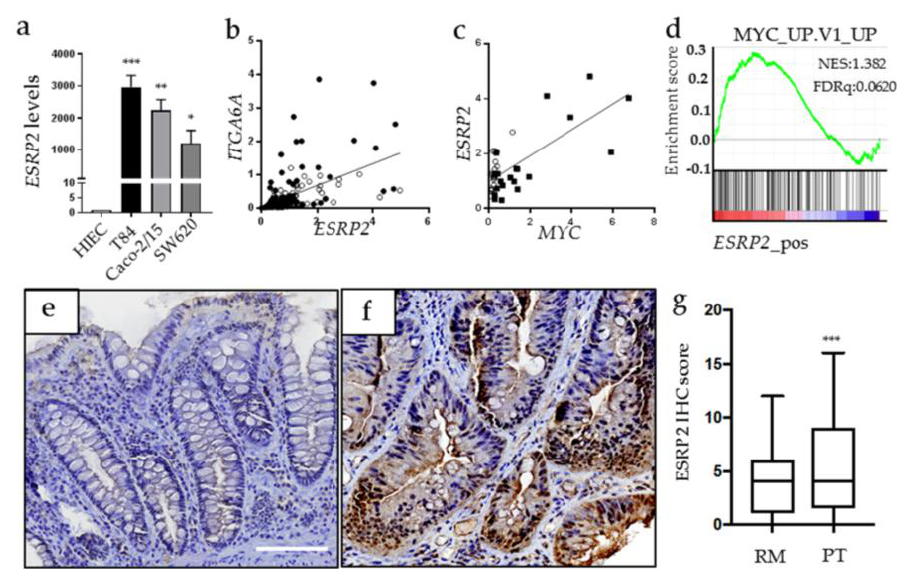
Figure 5. ESRP2 correlates with ITGA6A and MYC expression. ( a ) Evaluation of ESRP2 mRNA expression in normal human intestinal epithelial cells (HIEC) and a panel of CRC T84, Caco-2/15 and SW620 cells. * to ***: Statistically different ( p ≤ 0.05–0.001) from HIEC. ( b ) Correlation between ITGA6A and ESRP2 transcript expression in a set of 84 primary CRC tumors and their corresponding resection margins (RM). Pearson r = 0.5161, p ≤ 0.0001. ( c ) Correlation between MYC and ESRP2 transcript expression in a set of 20 primary CRC tumors and their resection margins (RM). Pearson r = 0.7243, p ≤ 0.0001. Open circle: RM; black square: CRC tumors. ( d ) GSEA plot of enrichment of MYC target genes of gene expression in high ESRP2 expression from the human colorectal cancer data set (GSE35896) using C2 MSigDB database. ( e , f ) ESRP2 immunohistochemical staining on tissue microarrays (TMA) containing CRC primary tumors and corresponding resection margins for 49 patients. Representative staining from a patient where ESRP2 score was found to be higher in cancer ( f ) than in resection margin ( e ). Scale bar = 100 µ m. ( g ) Distribution of immunostaining scores for ESRP2 in CRC primary tumors (PT) and corresponding RM. Boxes represent lower quartile, median, and upper quartile, whereas whiskers represents the lowest and highest immunostaining scores. ***: p < 0.001, Wilcoxon test.